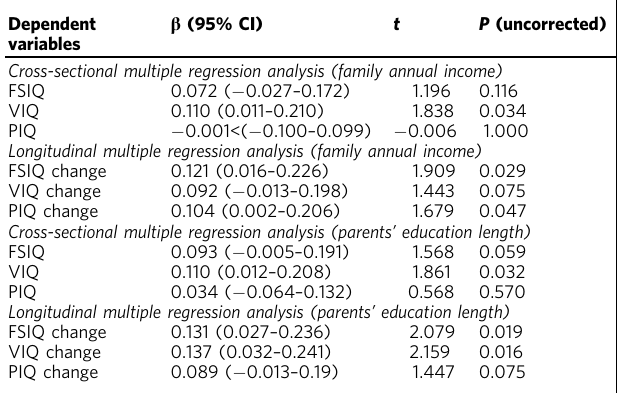
Table 3 Statistical values for the cross-sectional and longitudinal analyses of associations between family annual income or parents ’ education length and psychometric intelligence